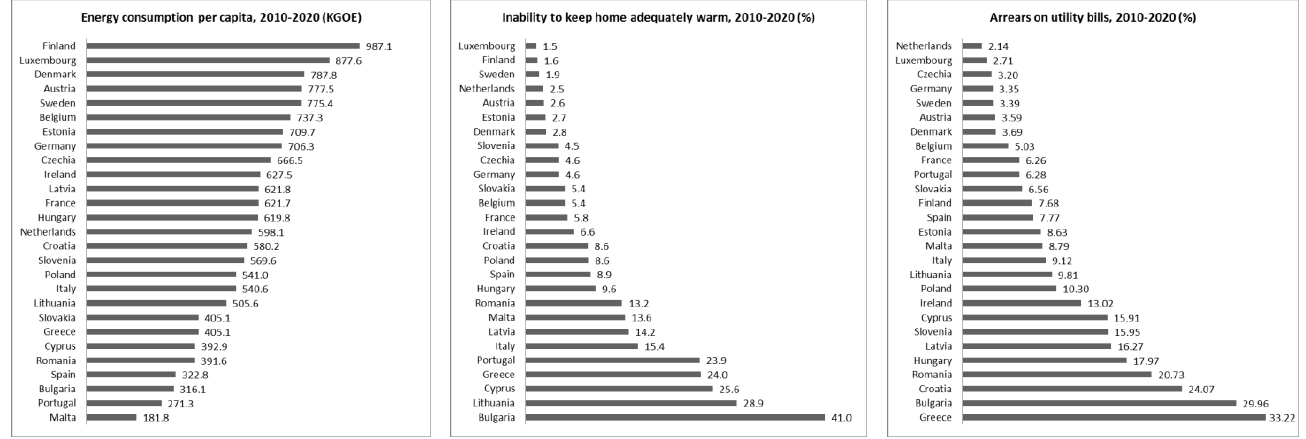
Figure 1. Energy poverty across the EU member states. Source: own research based on Eurostat data [81–83].